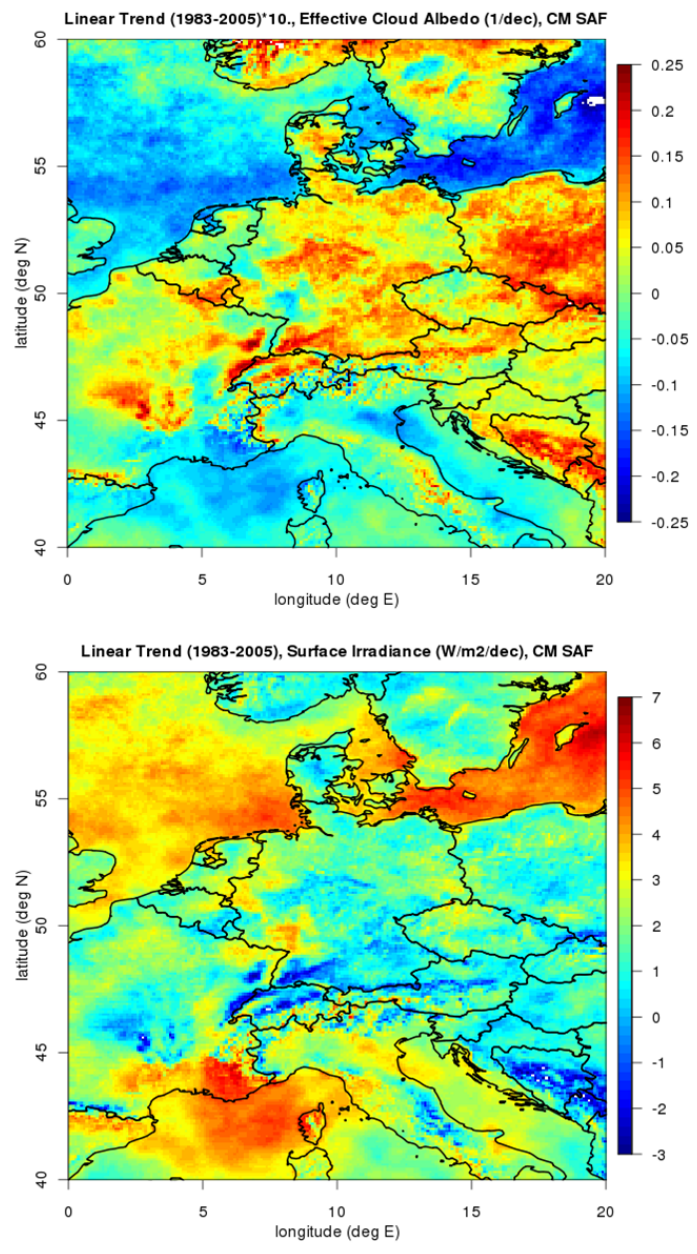
Figure 8. The result of the trend analysis for Central Europe. The trend in the effective cloud albedo (Top) and the trend in solar surface irradiance (SSI, (Bottom) ). The regions with negative trend in CAL transfers to positive trend in SSI and visa versa . Also local differences are apparent. The Rhine valley in the South-West of Germany shows a relative large positive trend in solar irradiance. This is of importance for the wine agriculture in this